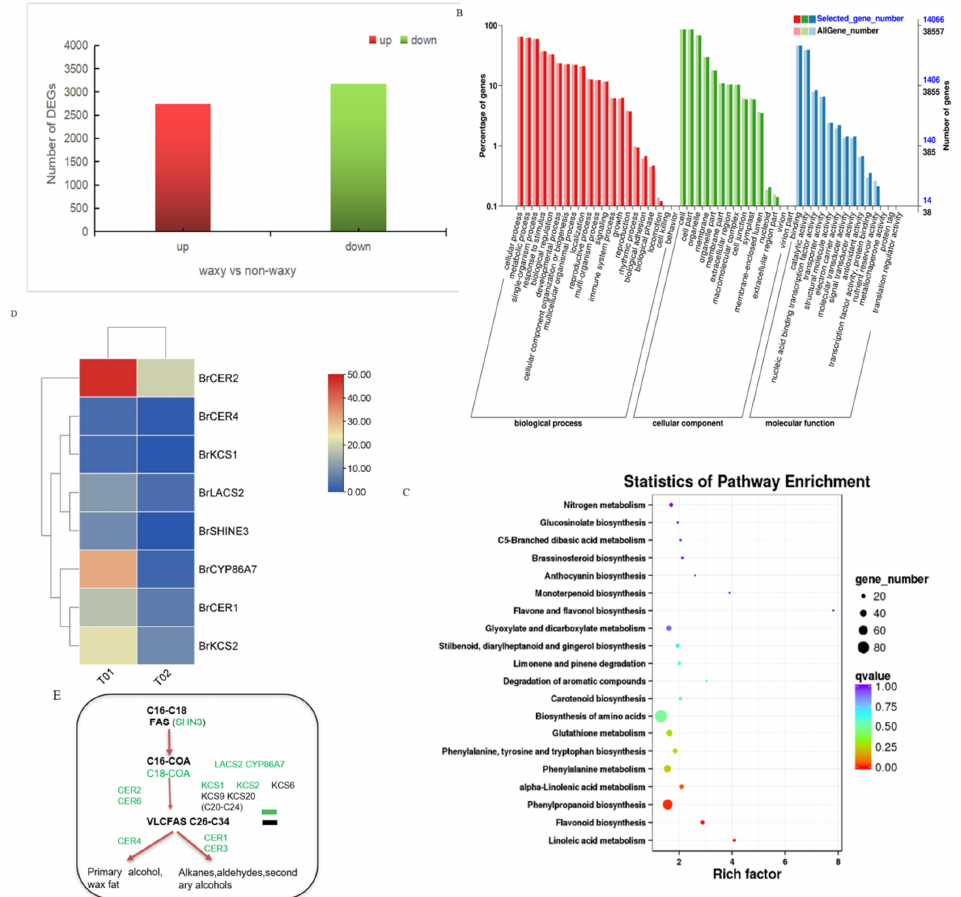
Figure 6. Transcriptome and differential gene pathway analysis.Number of DEGs ( A ), KEGG classification ( B ), KEGG enrichment map ( C ), Analysis of differential gene expression changes ( D ), Wax metabolic pathway ( E ).